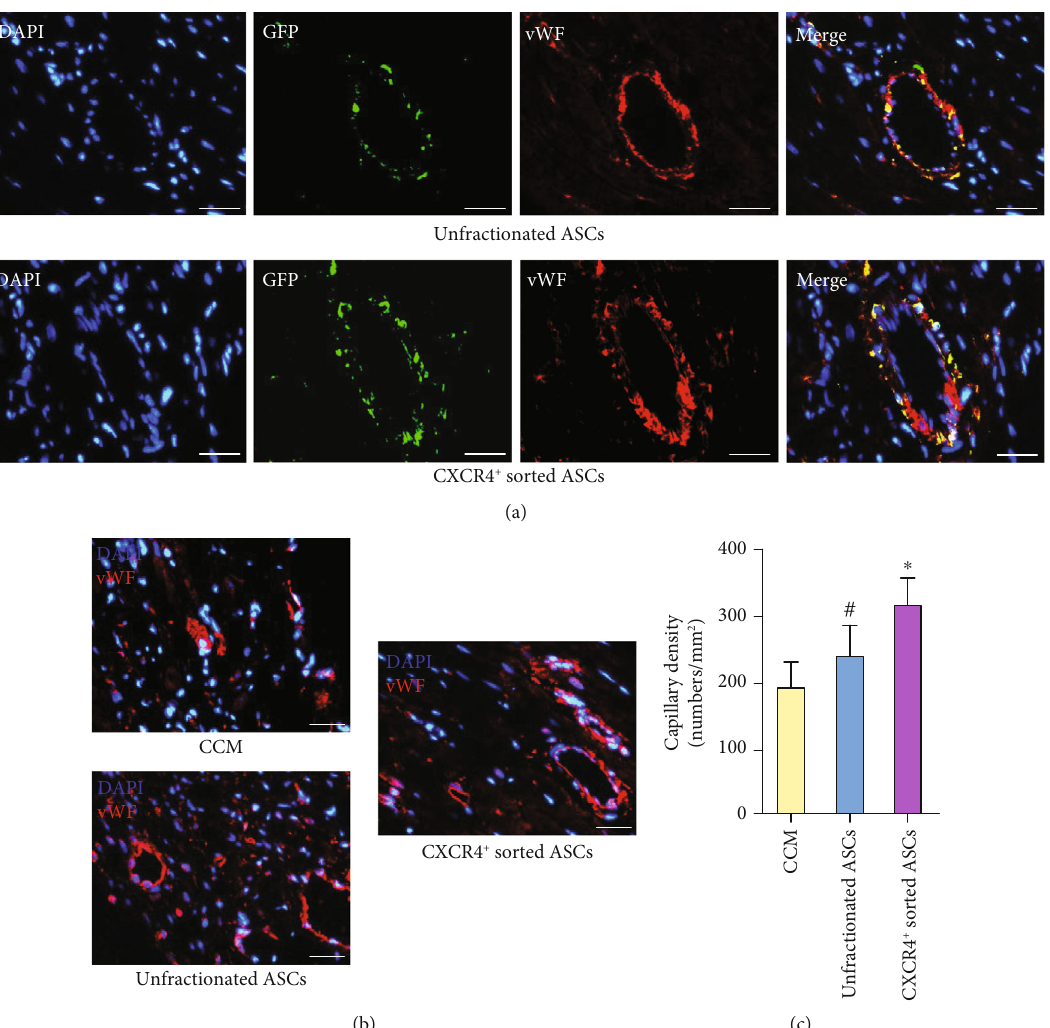
Figure 6: CXCR4 + sorted ASCs more e ff ectively improved capillary formation than did unfractionated ASCs in vivo. (a) Some implanted GFP + ASCs directly incorporated into capillary vasculature. (b) vWF staining positivity was present in the endothelial cells from capillaries. (c) Capillary density was signi fi cantly higher in CXCR4 + sorted ASC-treated rats than in unfractionated ASCs or CCM-treated rats. Scale bar represents 50 μ m. # p < : 05 versus CCM. ∗ p < : 05 versus unfractionated ASCs. Abbreviations: CXCR4: CXC-chemokine receptor 4; ASCs: adipose-derived stem cells; GFP: green fl uorescent protein; DAPI: 4 ′ ,6-diamidino-2-phenylindole; vWF: von Willebrand factor; CCM: cell culture